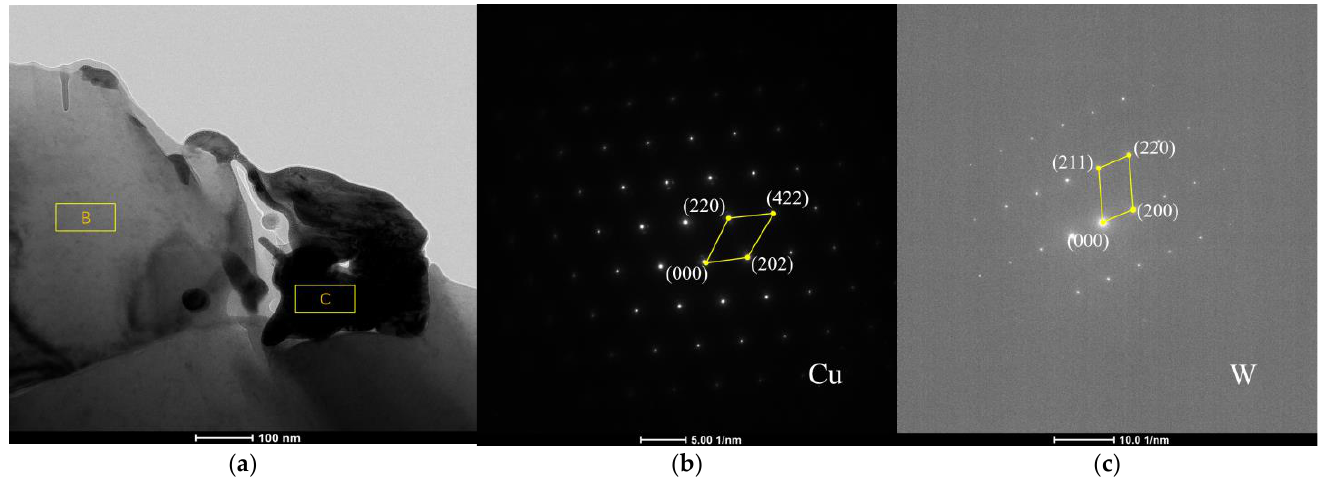
Figure 10. TEM images of W – Cu composite ( J = 2 A/dm 2 , f = 1500 Hz, d f = 40% and d r = 10%): ( a ) TEM image of W−Cu composite; ( b ) electron diffraction pattern of position B in Figure 10a; and ( c ) electron diffraction pattern of Position C in Figure 10a.